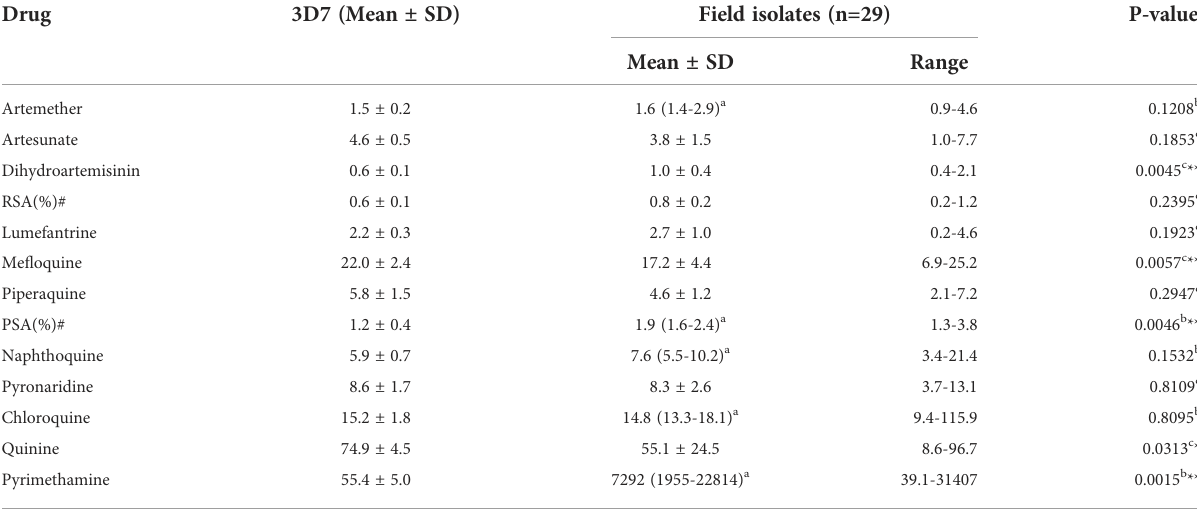
TABLE 1 In vitro susceptibilities (IC 50 in nM) of culture-adapted fi eld isolates from Ghana to 11 antimalarial drugs. Drug 3D7 (Mean ± SD) Field isolates (n=29)